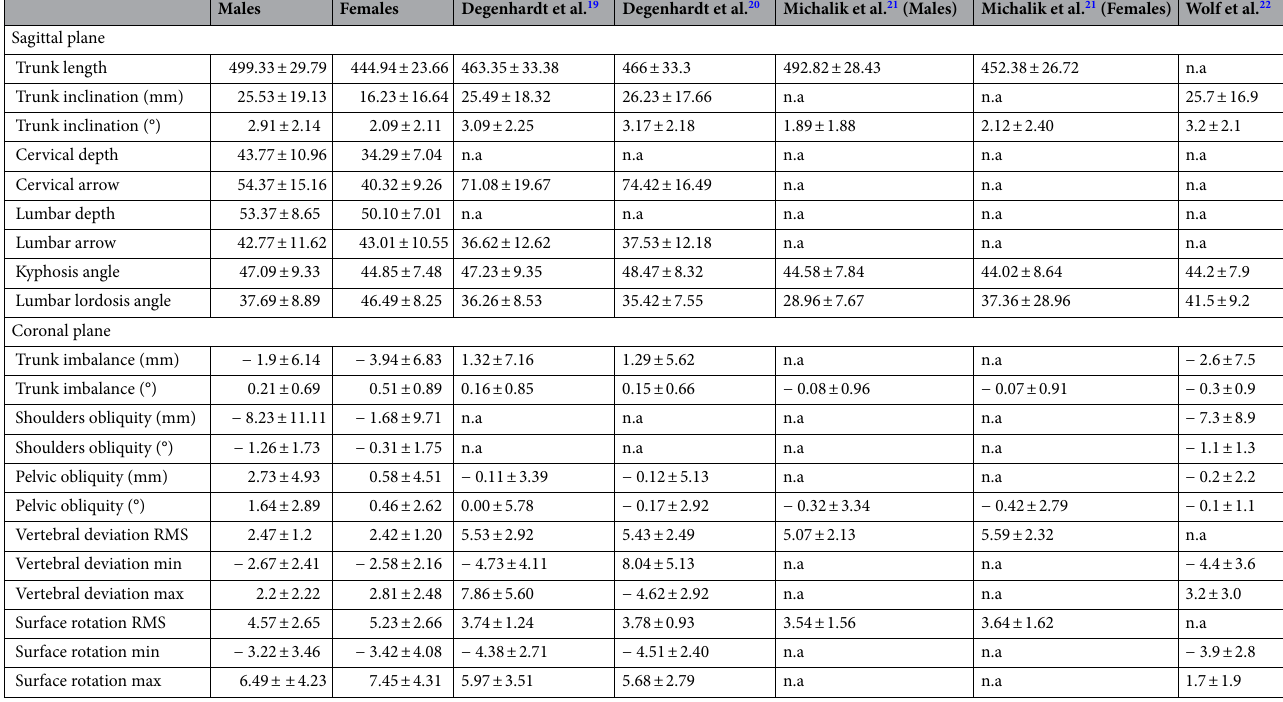
Table 3. Parameters comparison of mean ± SD with other studies. n.a not available, columns males (n = 85) and females (n = 90) represent our findings, Degenhardt et al. 19 (n = 30 M/F), Degenhardt et al. 20 (n = 30